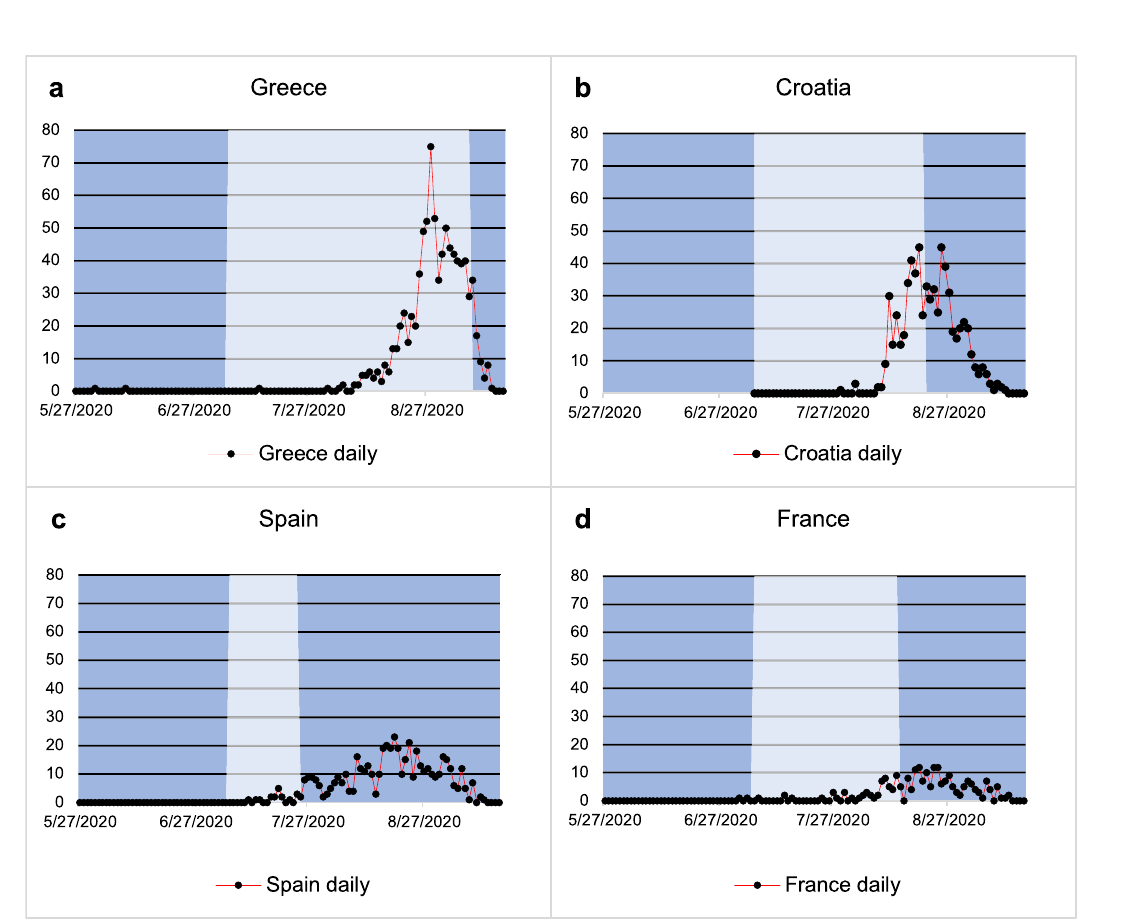
Fig. 1 Case ascertainment and distribution during the study period. a Timeline of the study period (27 May 2020 to 13 September 2020) and associated policy changes on travel introduced in England. Travel-related quarantine measures were assigned on a country by country basis from 4 July 2020. Travellers returning from countries that were on the ‘ closed travel corridors list 58 were required to quarantine for 14 days (*reduced to 10 days on 15/12/